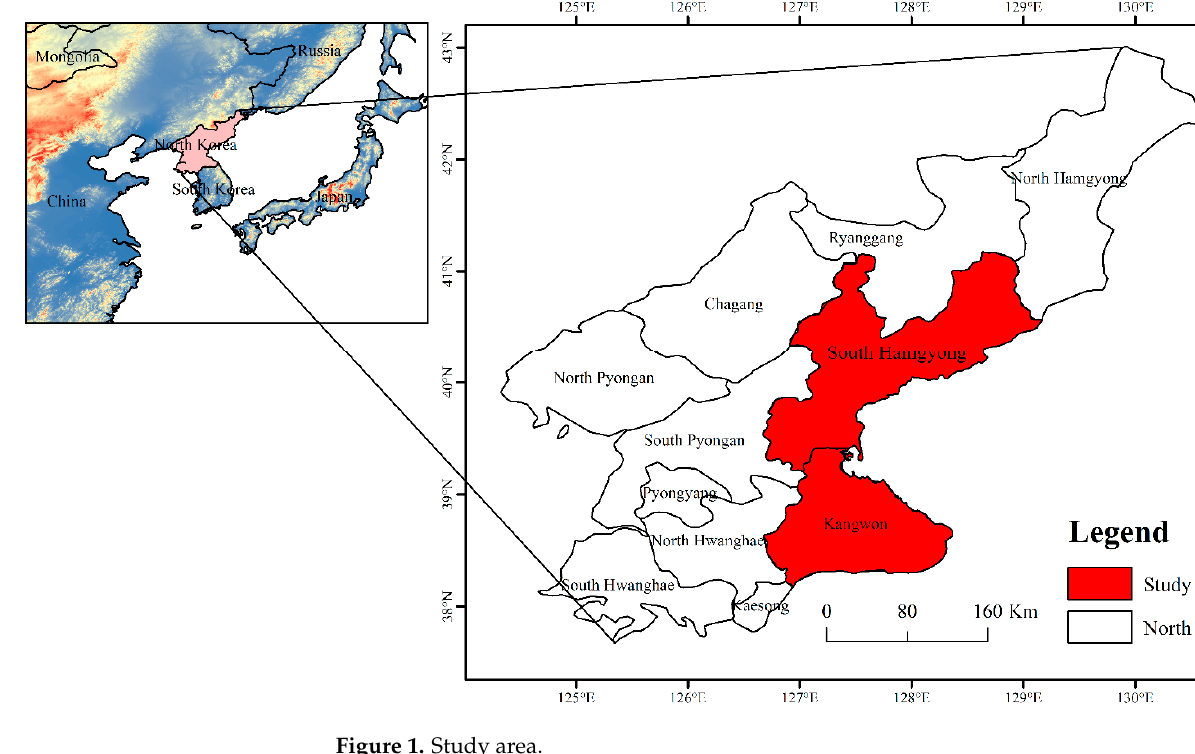
Figure 1. Study area.